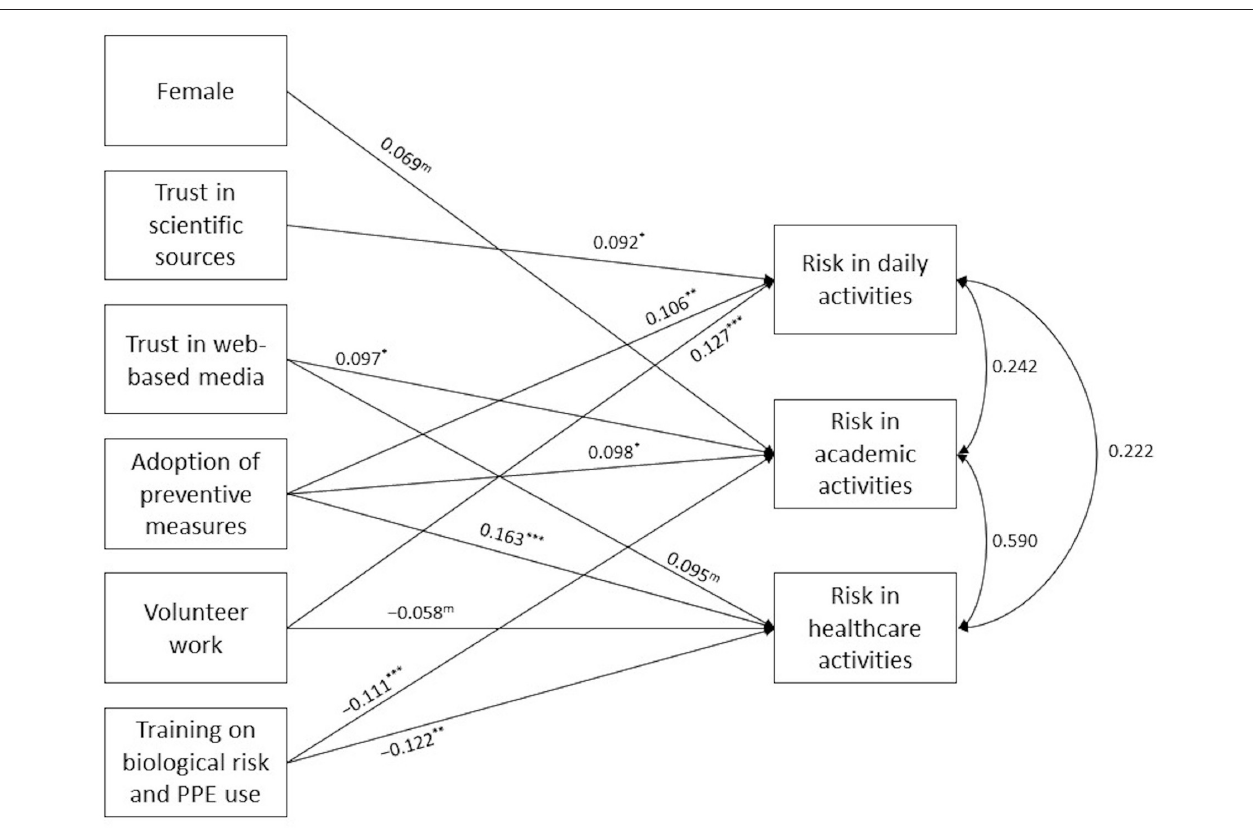
FIGURE 1 | Path diagram depicting estimates from the trimmed path model. Single-headed arrows indicate the relationship between exogenous and endogenous variables. The number reported over each single-headed arrow represents the standardized regression coefficient. Double-headed arrows and the values reported near them indicate the correlation between the edogenous